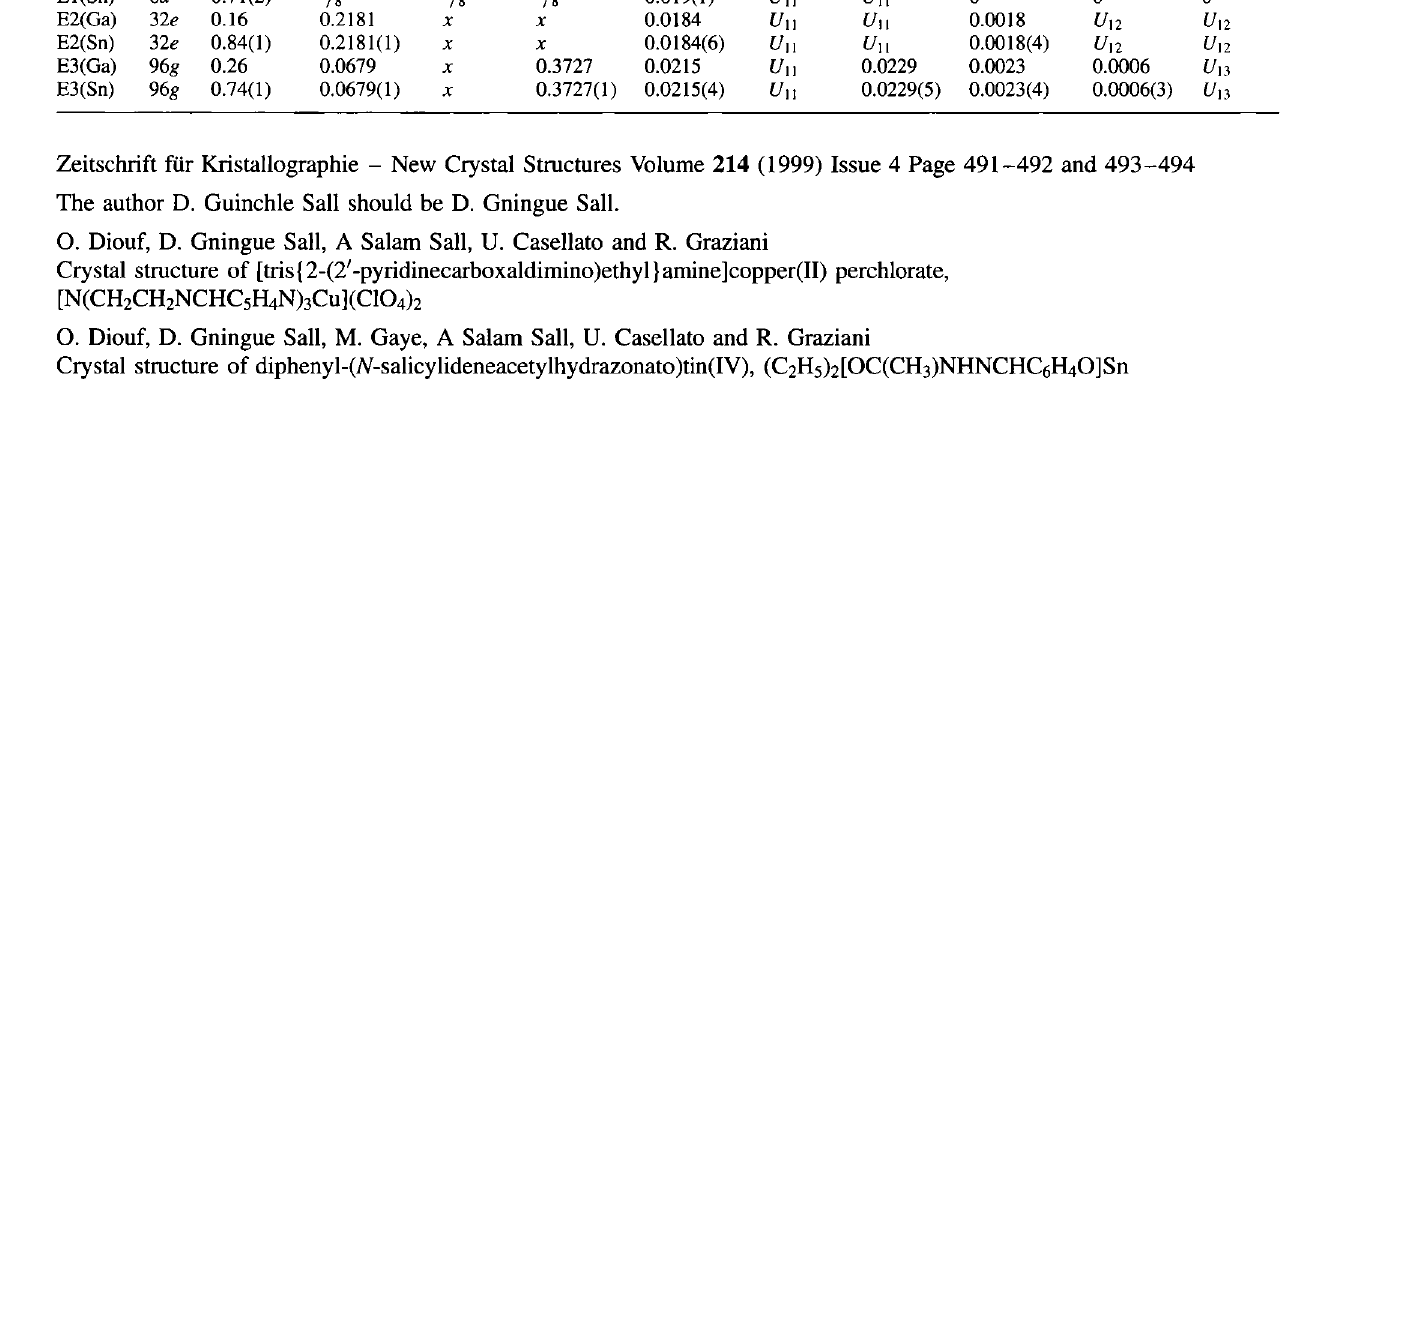
Table 2. Atomic coordinates and displacement parameters (in Ä 2